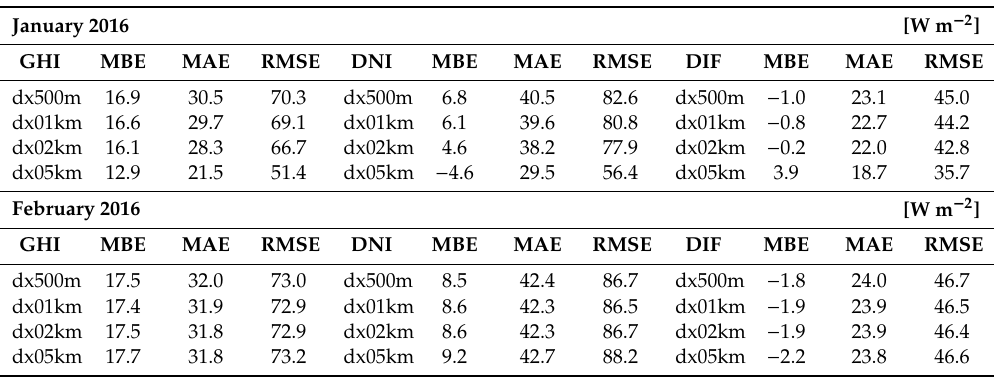
Table 3. Same as Table 2, but for the Exp-Winter (January (upper tables) and February (lower tables)) in